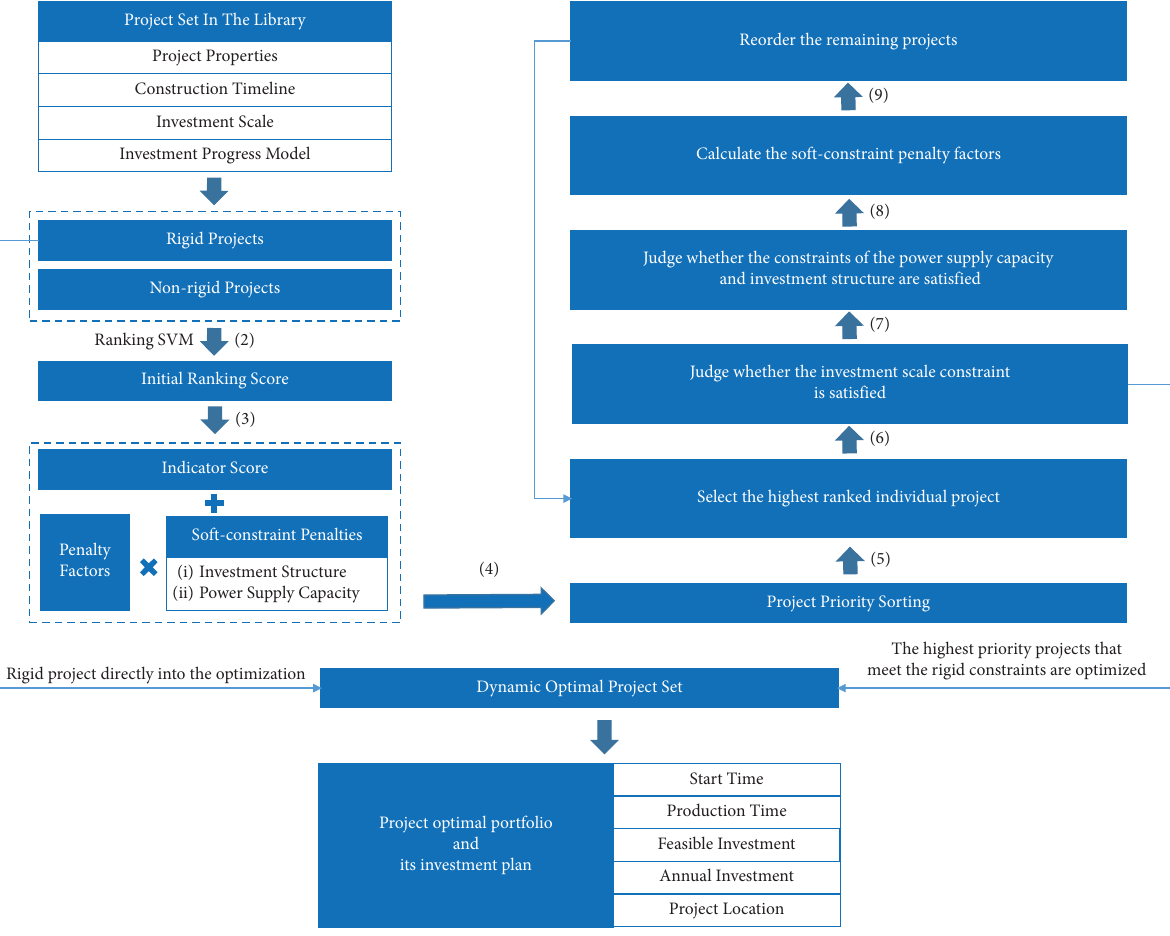
Figure 1: Overall fowchart architecture of the proposed